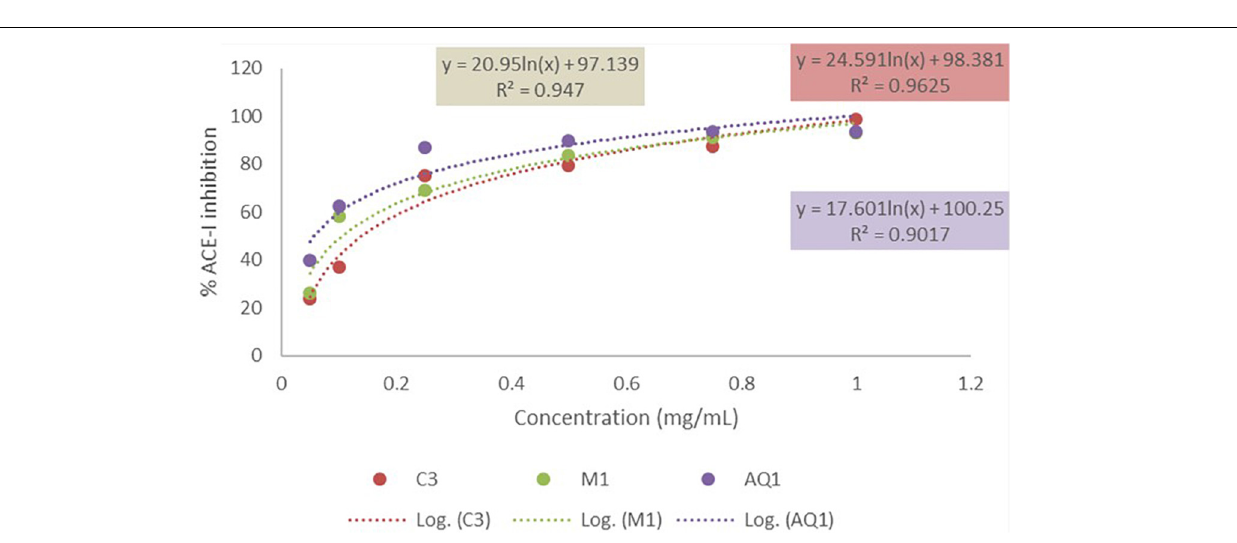
FIGURE 5 | IC 50 valus of mesopelagic hydrolysates MI and C3 and aqueous extract AQ1 for Angiotensin-1-converting enzyme (ACE-1) ( n = 3). C, combined (Krill and M. muelleri